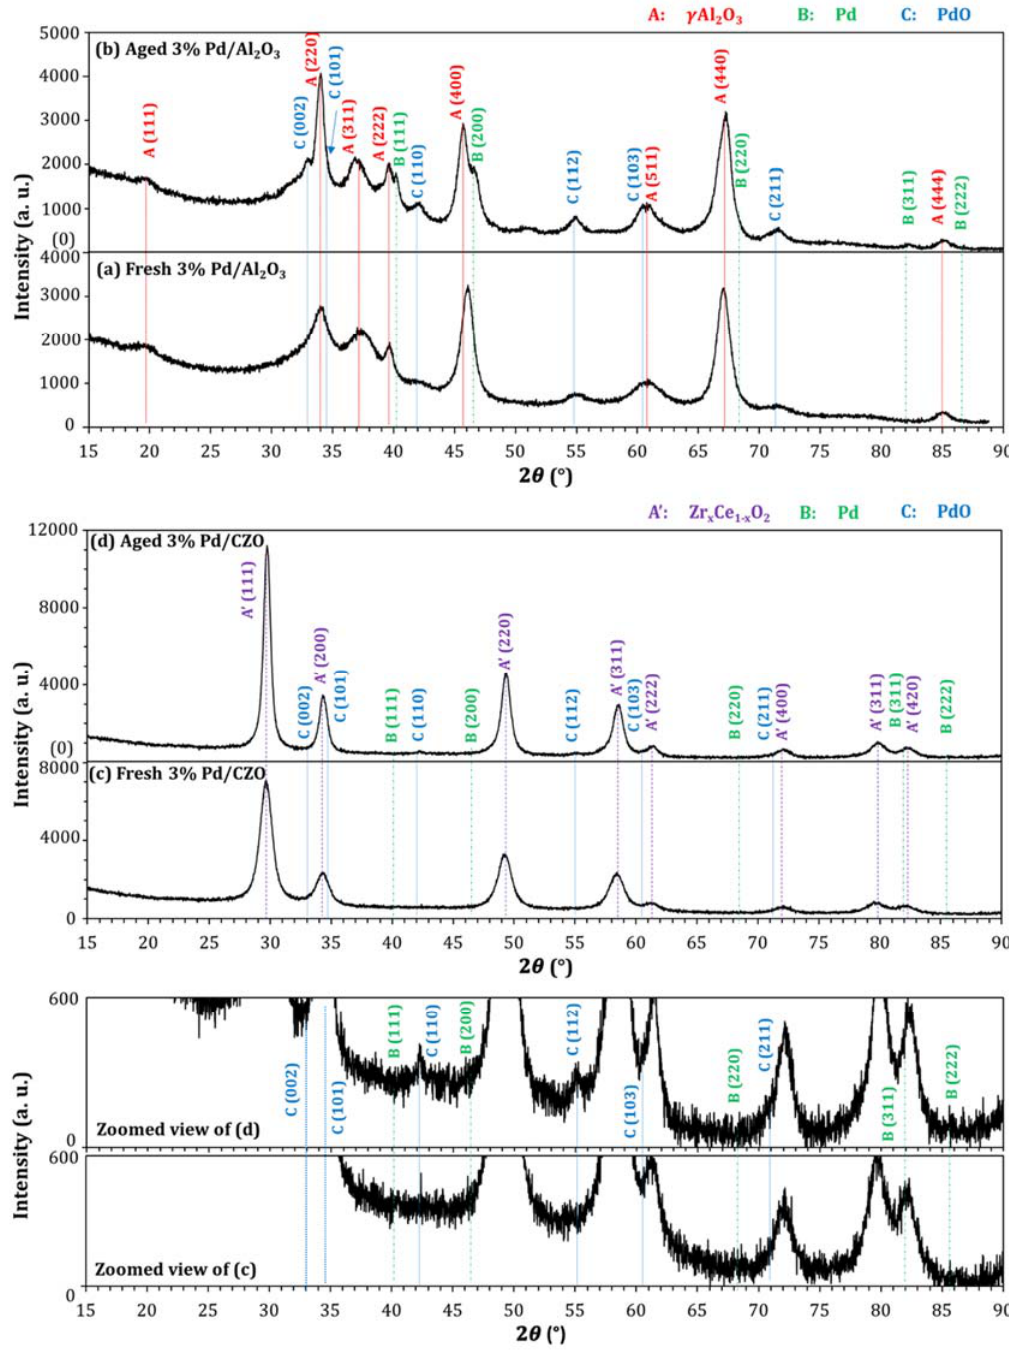
Figure 9. X-ray diffraction (XRD) patterns for ( a ) Fresh 3% Pd/Al 2 O 3 ; ( b ) Aged 3% Pd/Al 2 O 3 , ( c ) Fresh 3% Pd/CZO; ( d ) Aged 3% Pd/CZO; and the zoomed views of ( c , d ). Aging condition: 1050 °C in air for 5 min. XRD patterns were obtained by using Cu- K α 1 radiation ( λ = 1.5406